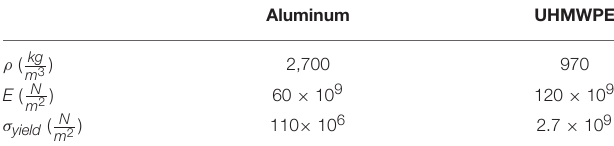
TABLE 1 | Material